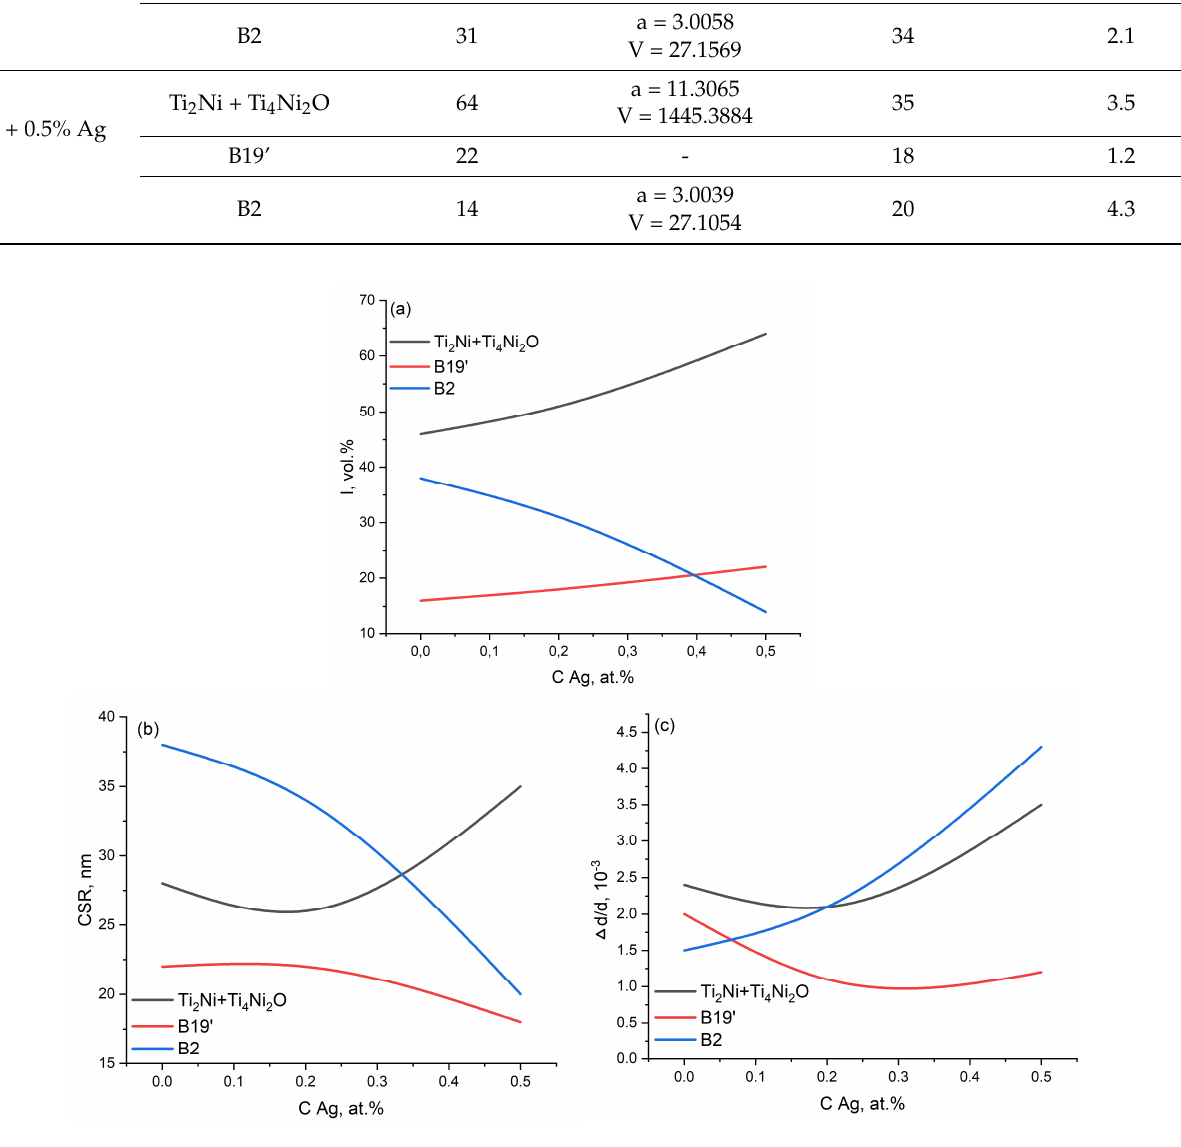
Figure 2. Concentration dependence according to the results of X-ray diffraction analysis of TiNiAg: ( a ) volume fraction of the phases; ( b ) CSR values; ( c ) microdistortions. Table 1. X-ray analysis of TiNiAg alloys.